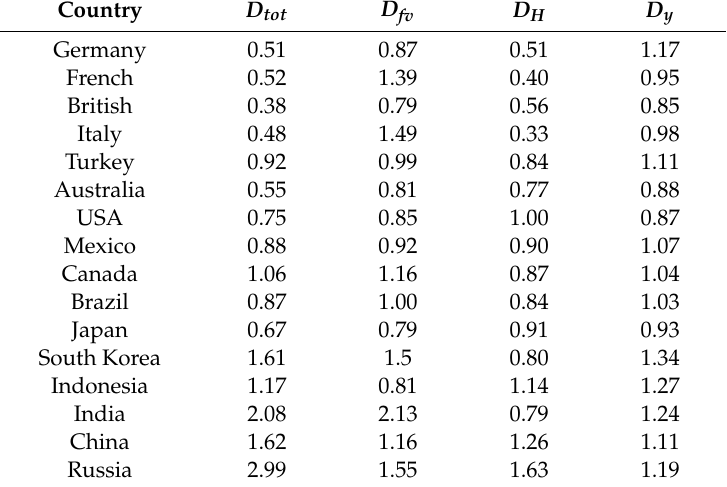
Table 1. Multiplicative structural decomposition analysis (SDA) of EEI di ff erences in G20 countries in